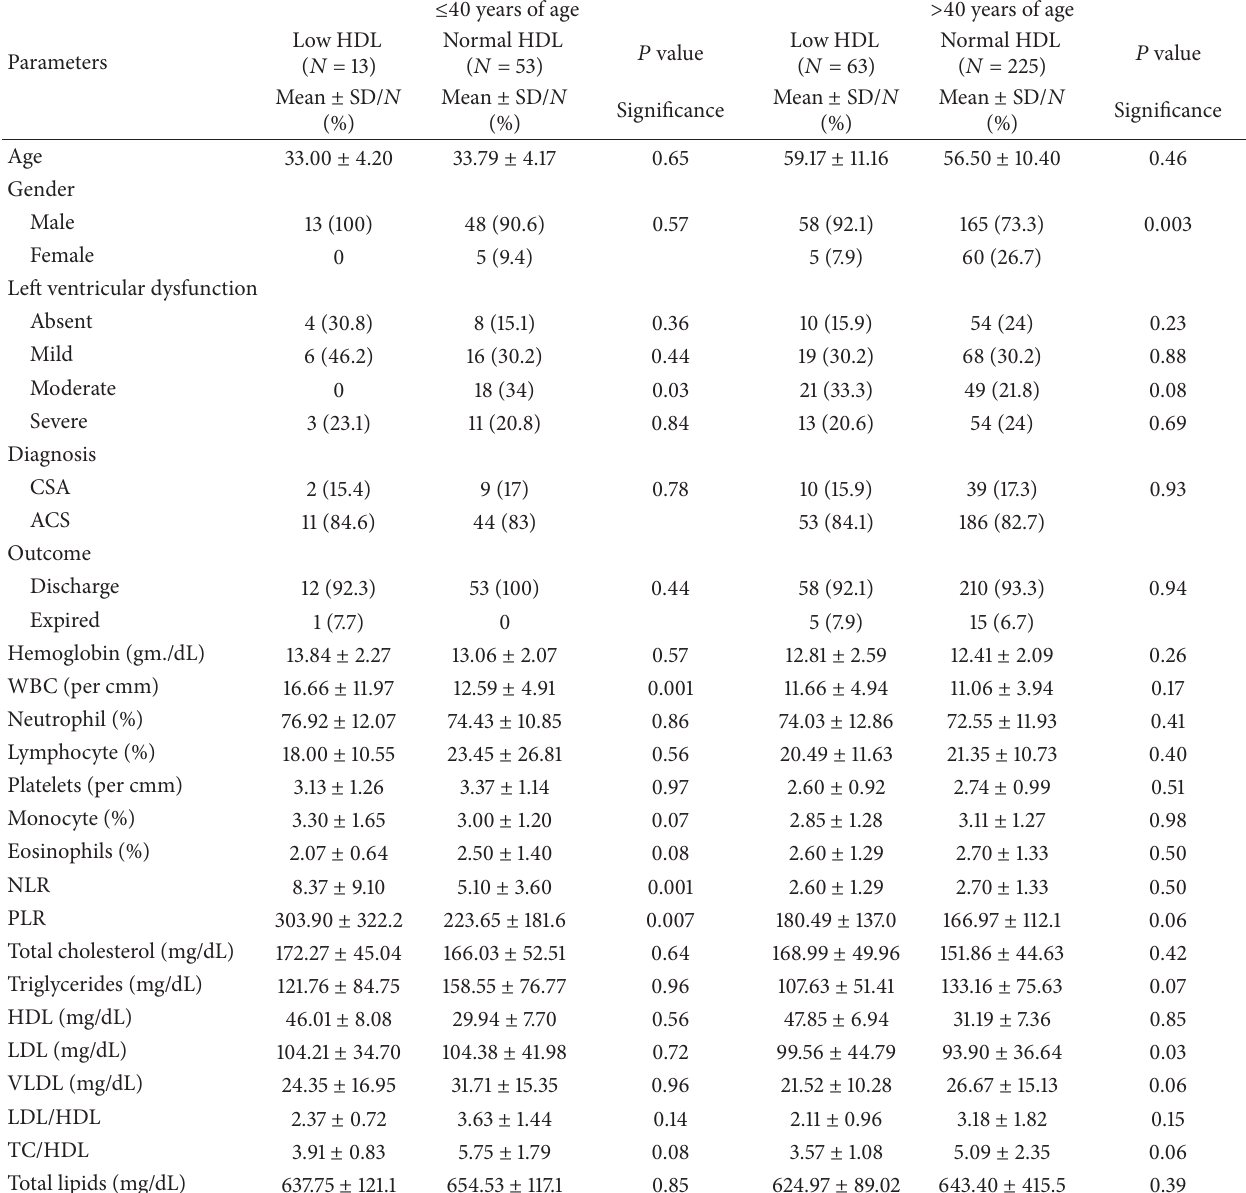
Table 5: Demographic, clinical, and laboratory characteristics according to HDL-C levels in young versus old population.